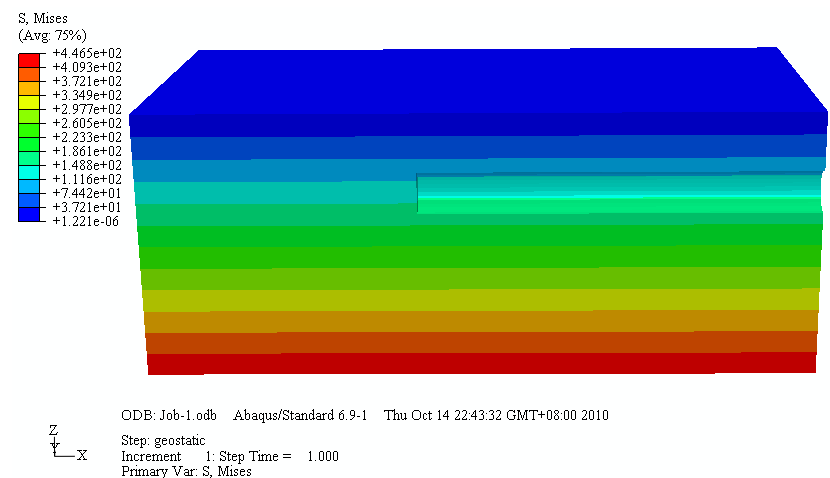
Figure 10. von Mises stress clouds of the initial state (kPa).